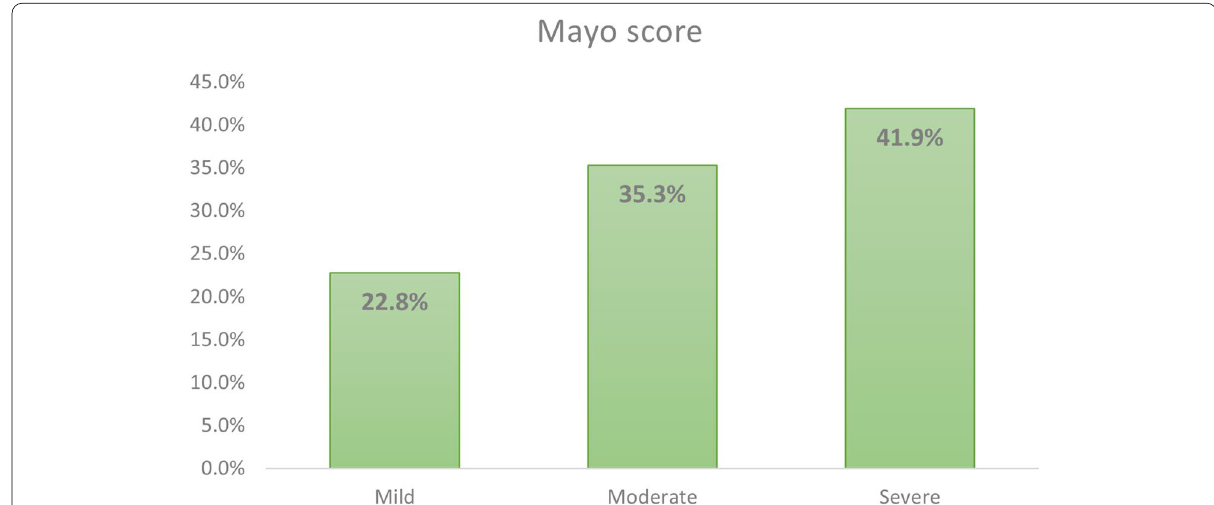
Fig. 5 Degree of severity of ulcerative colitis (Mayo score) at index presentation